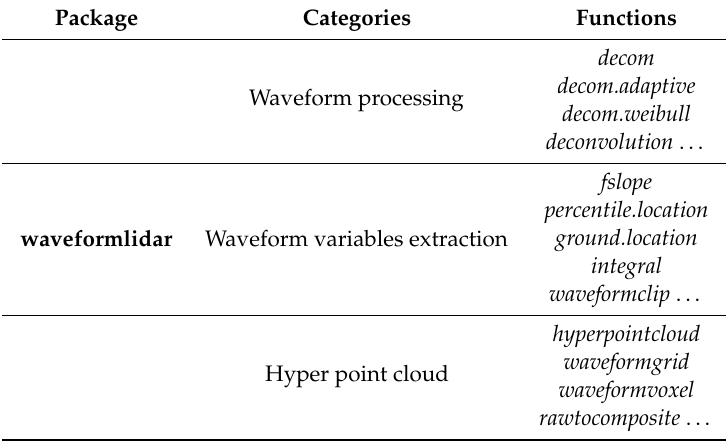
Table 2. Summary of major functions of waveformlidar